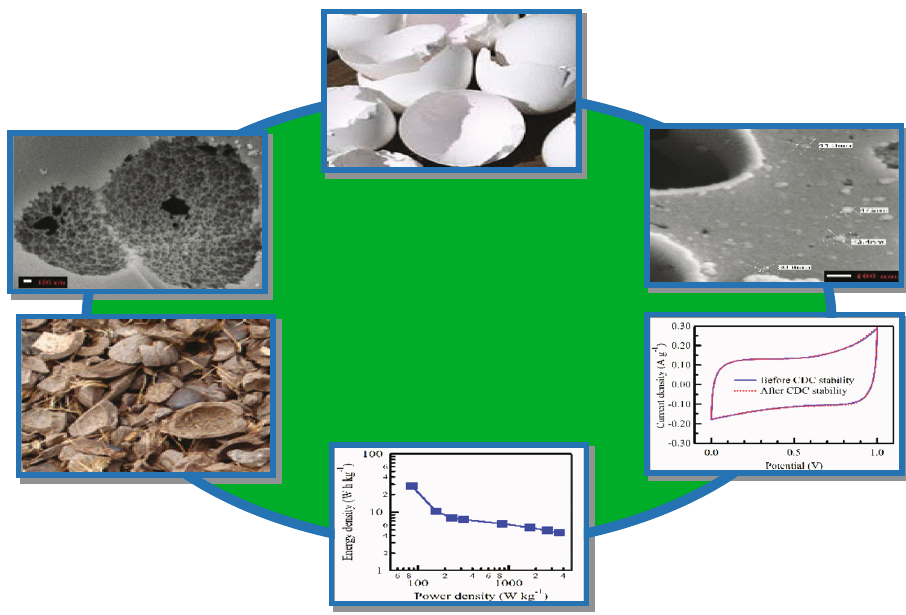
Figure 35: Schematic of the recovery of CaO from eggshells and AC from palm kernel shells. Copied with permission from ref. [ 28 ] ; Springer Nature, 2018.